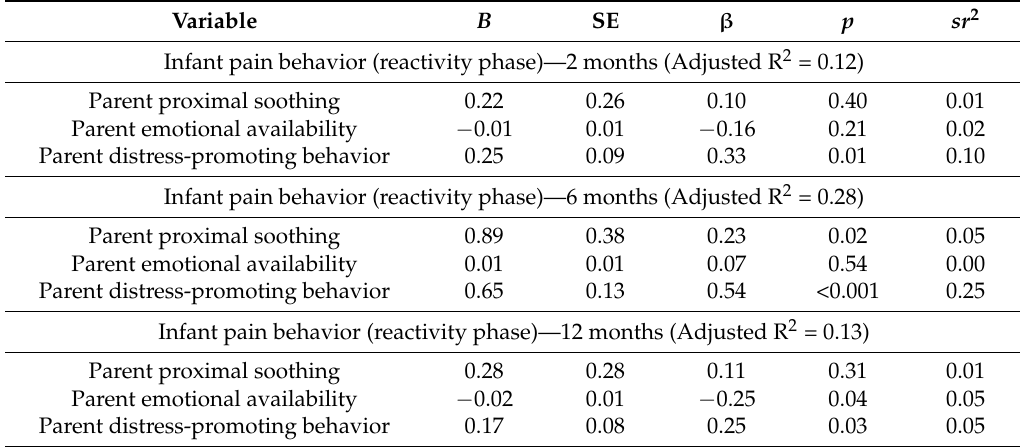
Table 3. Summary of multiple regression analysis for infant pain behavior during the reactivity